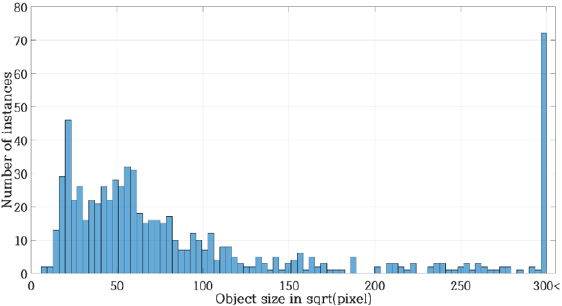
Figure 6. Number of instances and defect size (pixel).